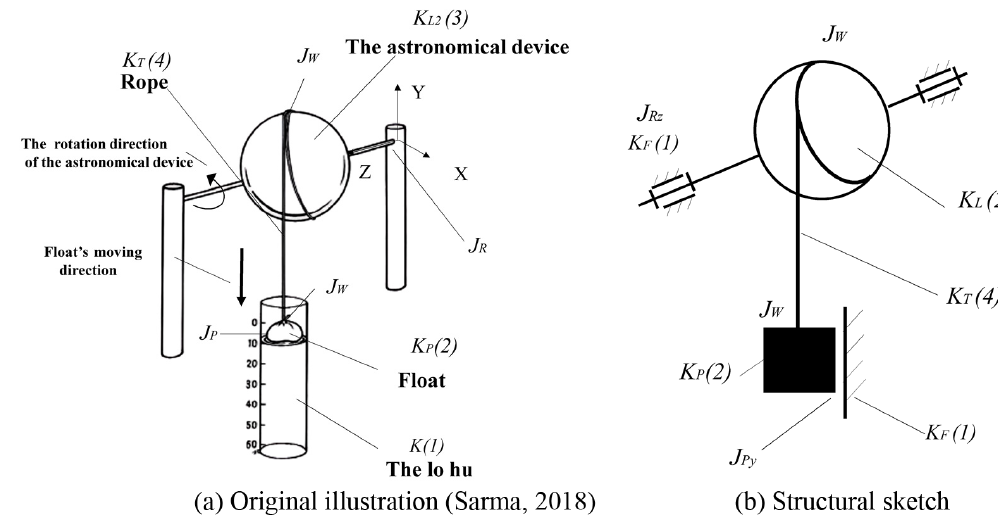
Figure 7. Reconstruction of ¯Aryabhaa’s self-propelled